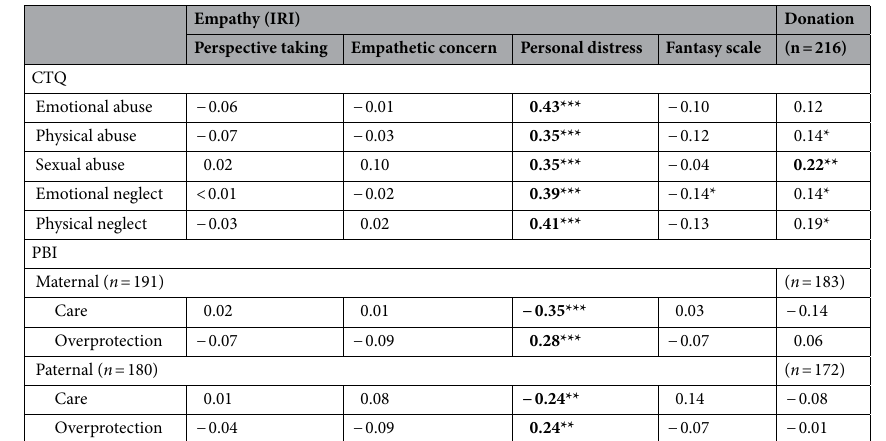
Table 2. Spearman correlation coefficients. CTQ childhood trauma questionnaire, PBI parental bonding instrument, IRI interpersonal reactivity index. Correlation CTQ ~ IRI based on N = 228, other correlations reduced according to reduced sample sizes due to missing values on the respective scale; significant correlations after Bonferroni correction are printed in bold. *** p < 0.001, ** p < 0.004 (adjusted alpha level after Bonferroni correction for 14 variables), * p <